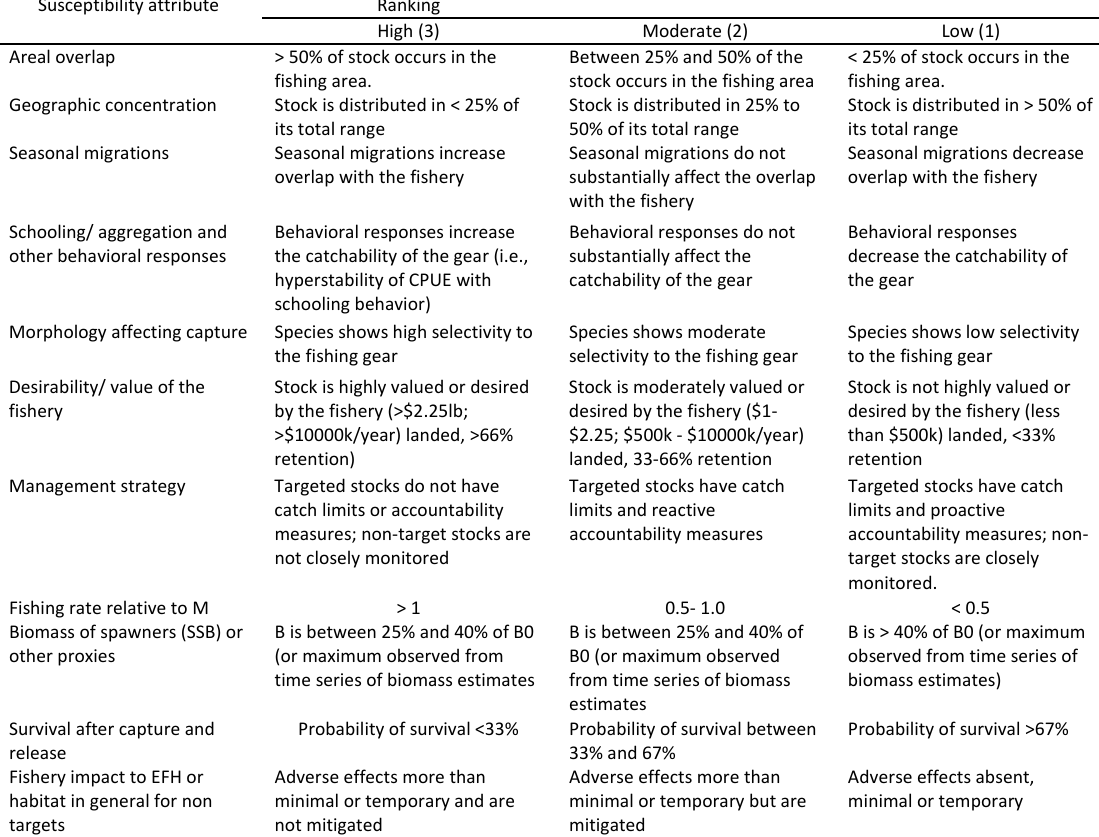
Table 2: Susceptibility attributes and rankings